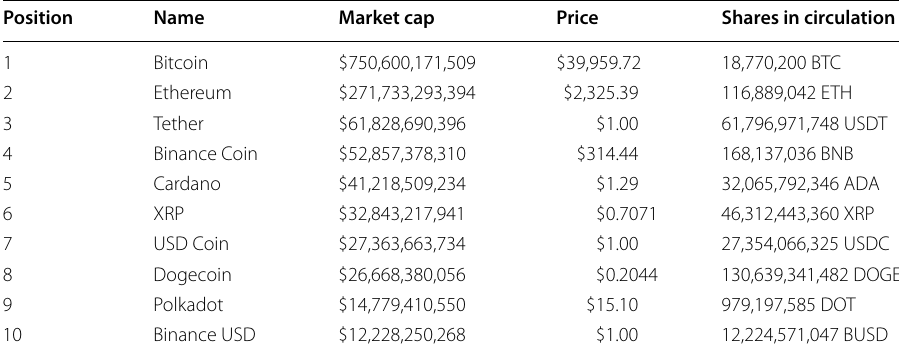
Source : Own compilation. Data collected from CoinMarketCap